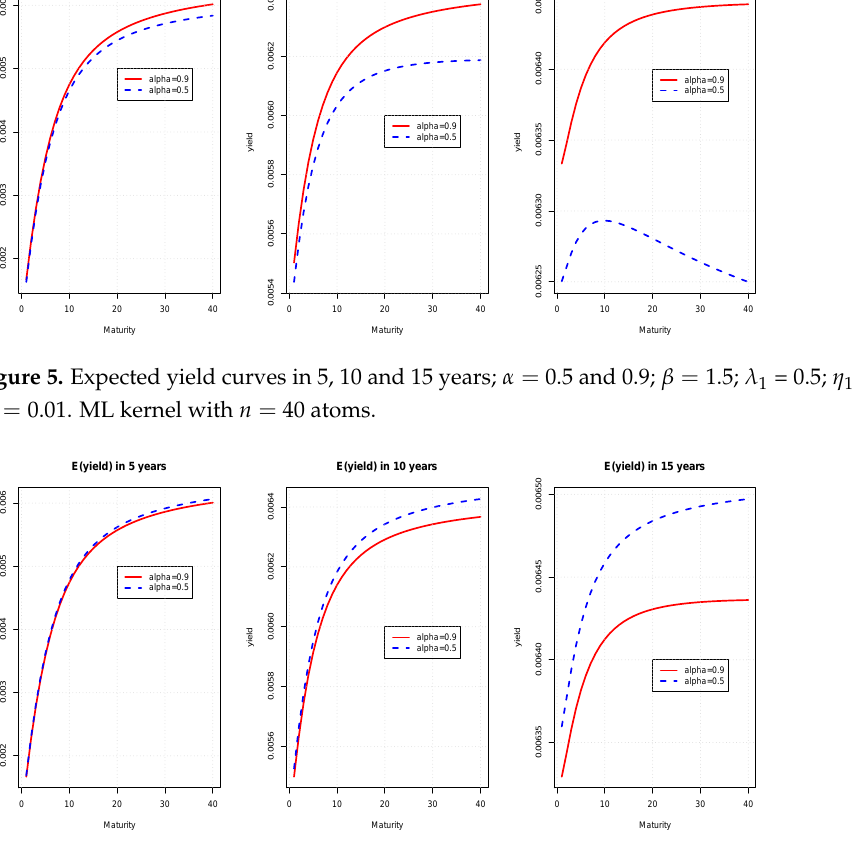
Figure 6. Expected yield curves in 5, 10 and 15 years; α = 0.5 and 0.9; β = 1.5; λ 1 = 0.5; η 1 = − 0.002; σ 1 = 0.01. PML kernel with n = 40